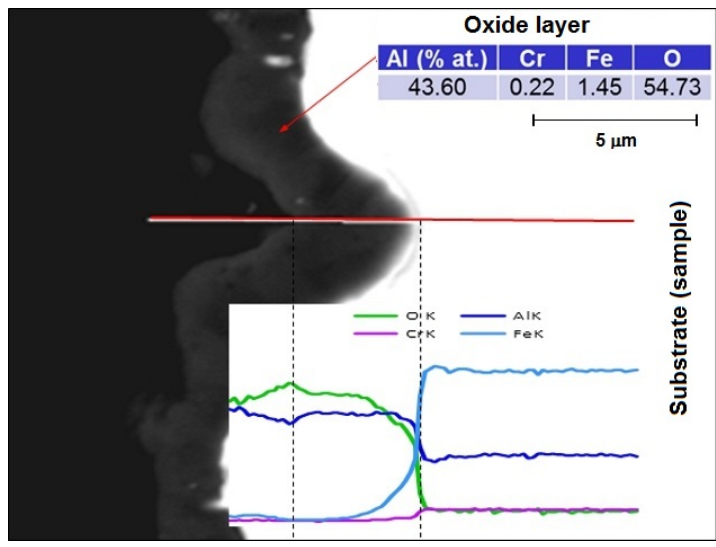
Figure 5. Microanalysis of the chemical composition of the oxide layer at 1200 °C/50 h on the